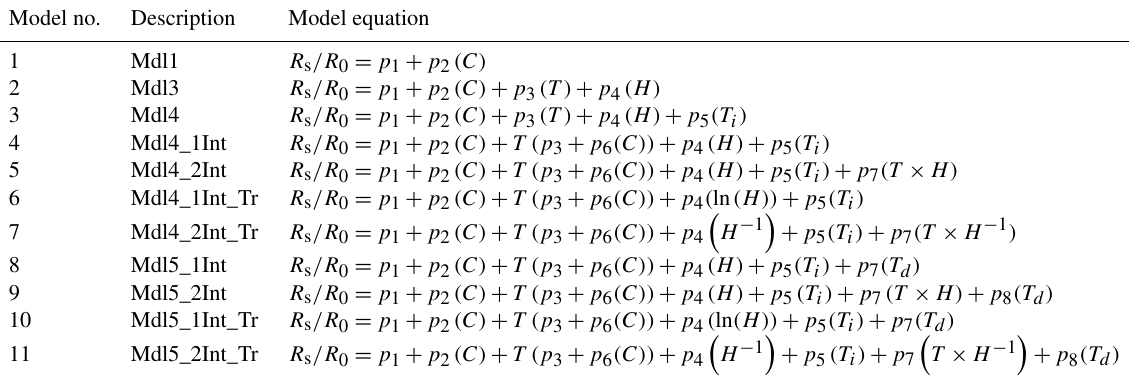
Table 2. Calibration models. Model